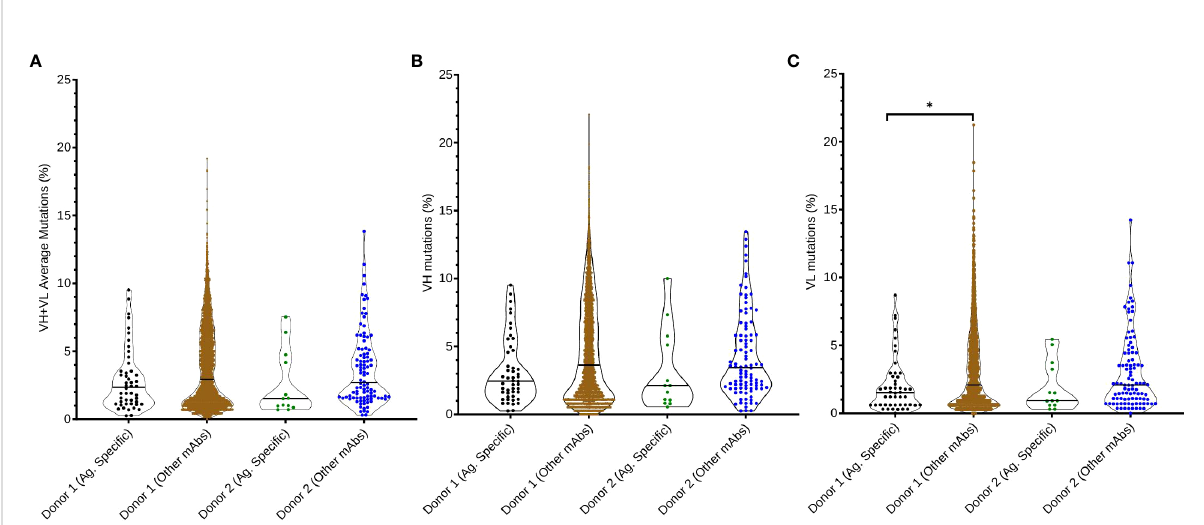
FIGURE 4 Somatic hypermutation analysis of anti-SARS-CoV-2 Spike antibodies compared with non-SARS-CoV-2 Spike antibodies in donor immune repertoires. (A) Average SHM percentage of both VH and VL genes in the SARS-CoV-2 Spike-speci fi c repertoire, compared with the rest of the donor ’ s immune repertoire. Percentage of somatic hypermutations in (B) heavy chain variable regions and (C) light chain variable regions is also reported for each donor and dataset. Pairwise comparisons were performed using the K-S test, and all statistically signi fi cant comparisons are noted (*p< 0.0083 after correcting for multiple comparisons using Bonferroni correction); any non-statistically signi fi cant comparisons are